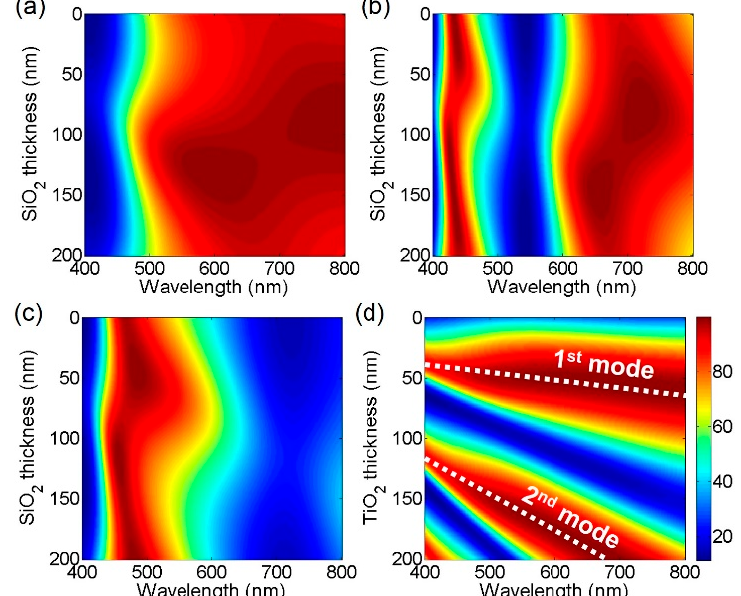
Figure 2. 2D contour plots of optical absorptions as a function of a wavelength and a SiO 2 layer thickness for ( a ) blue, ( b ) green and ( c ) red colors. ( d ) 2D contour map of absorptions as a function of a wavelength and a thickness of TiO 2 .